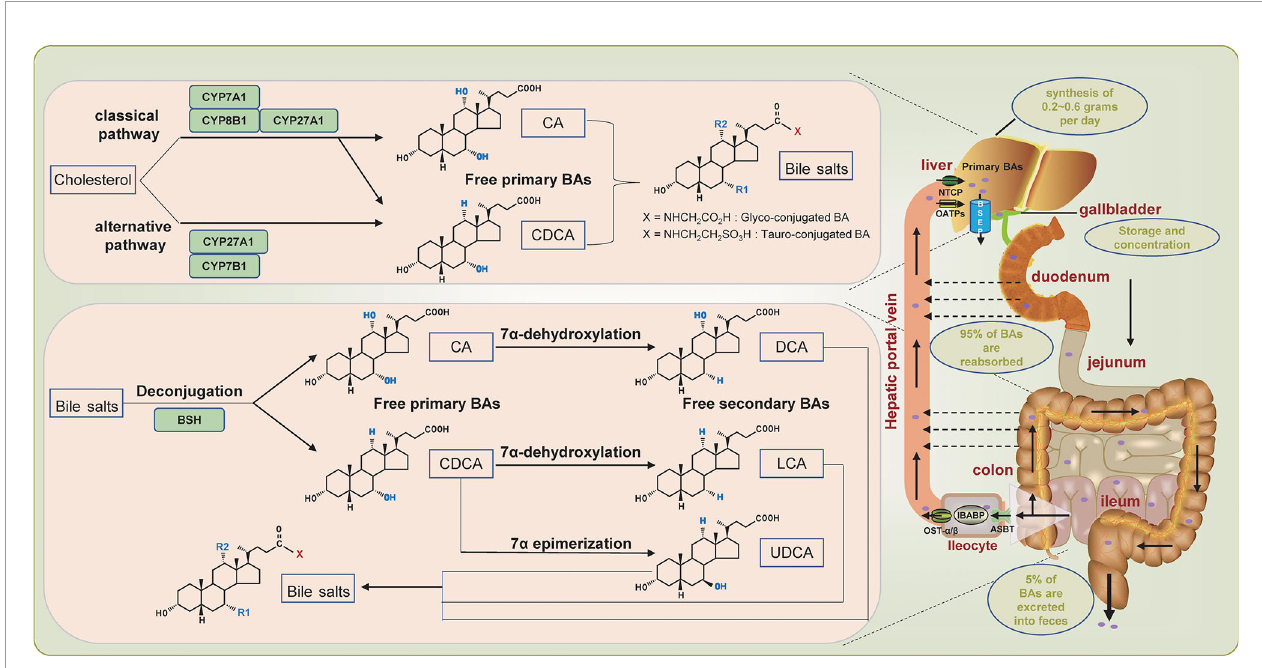
FIGURE 1 | Overview of enterohepatic circulation of bile acids. The dashed arrow indicates passive